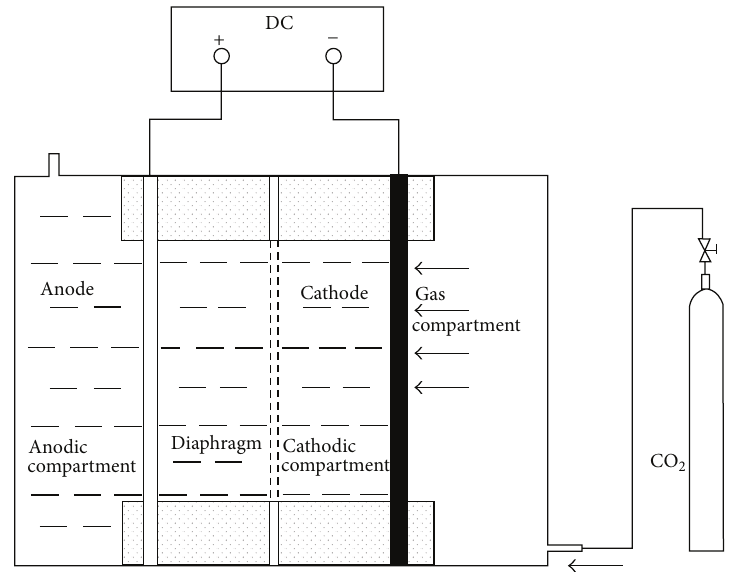
Figure 1: Schematic diagram of electrolysis apparatus.